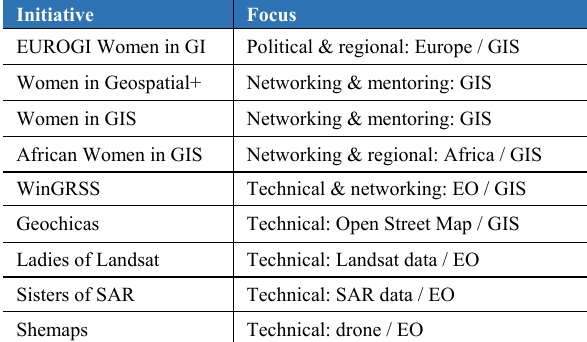
Table 1. Examples of EO*GI initiatives with gender-related